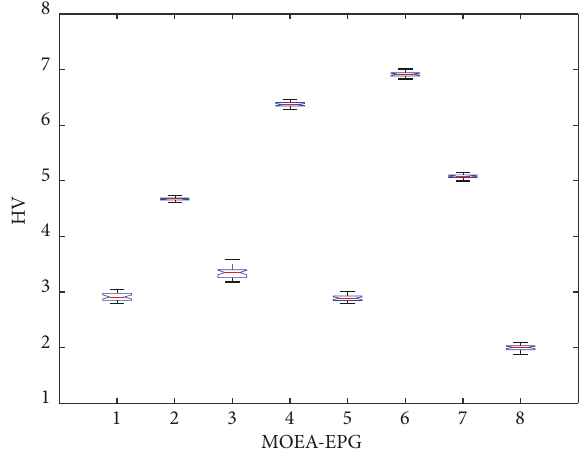
Figure 7: The boxplots of HV values for MOEA-EPG under the accuracy-coverage space for different data sets. 1: Movielens 1, 2: Movielens 2, 3: Movielens 3, 4: Movielens 4, 5: Netflix 1, 6: Netflix 2, 7: Netflix 3 and 8: Netflix